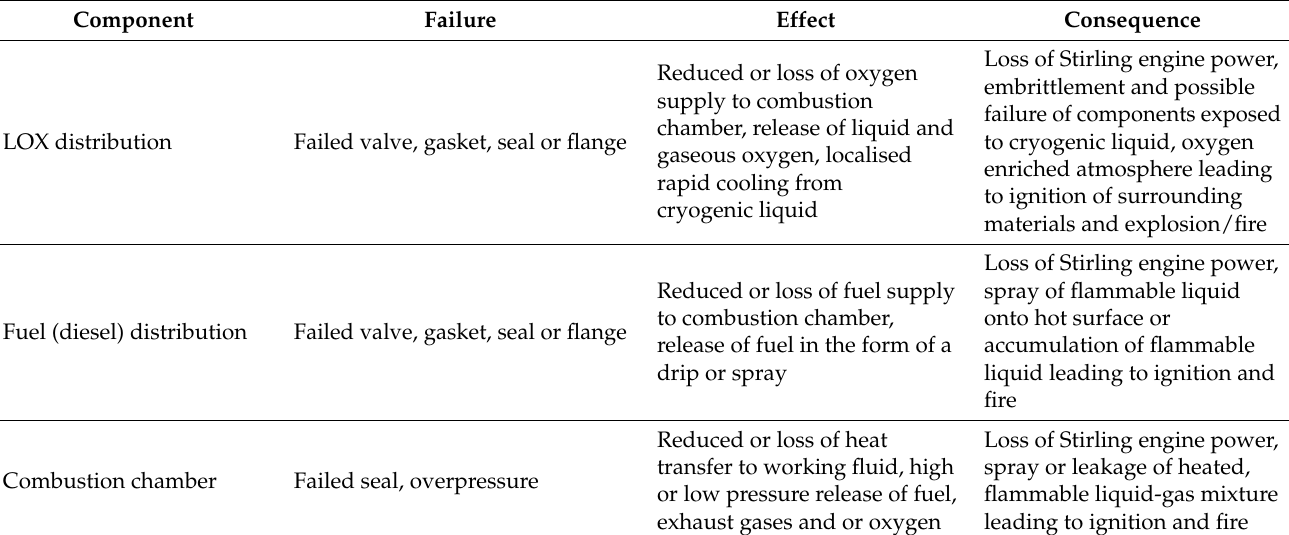
Table 6. Stirling Engine System Failures Leading to